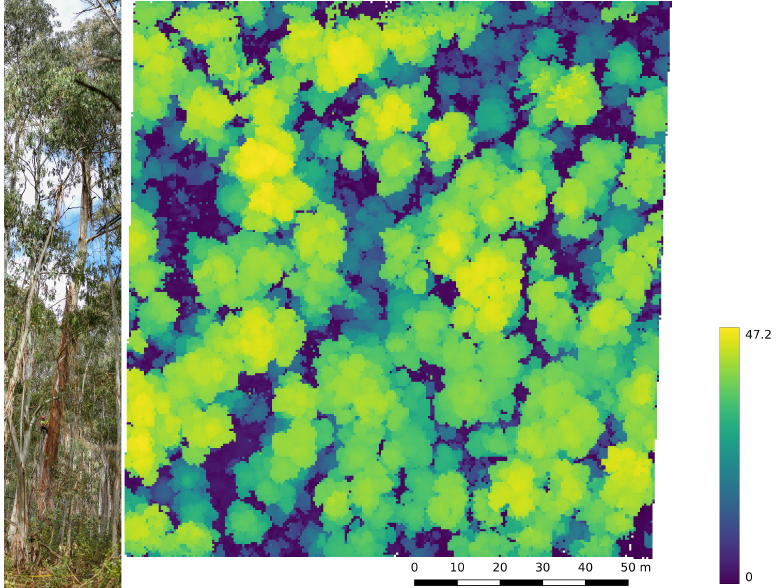
Figure 1. Photo of the vegetation type on the left and canopy height map with 0.5m grid cell resolution of Tumbarumba on the